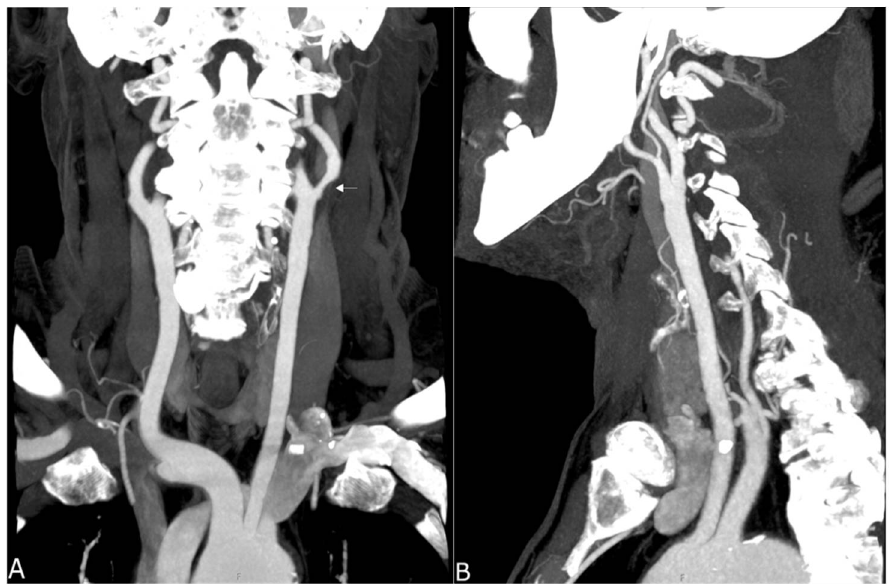
Figure 4. Maximum intensity projection of a supra-aortic UHR-CTA, ( A ) coronal projection showing an internal carotid artery plaque (white arrow) as well as contrast and delineation of, e.g., the thyrocervical trunk; ( B ) sagittal projection.